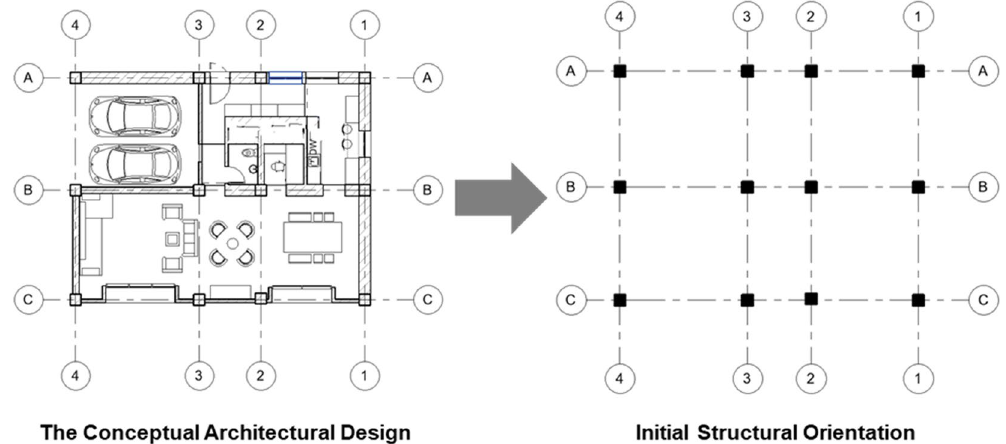
Figure 3. Grid and structural columns